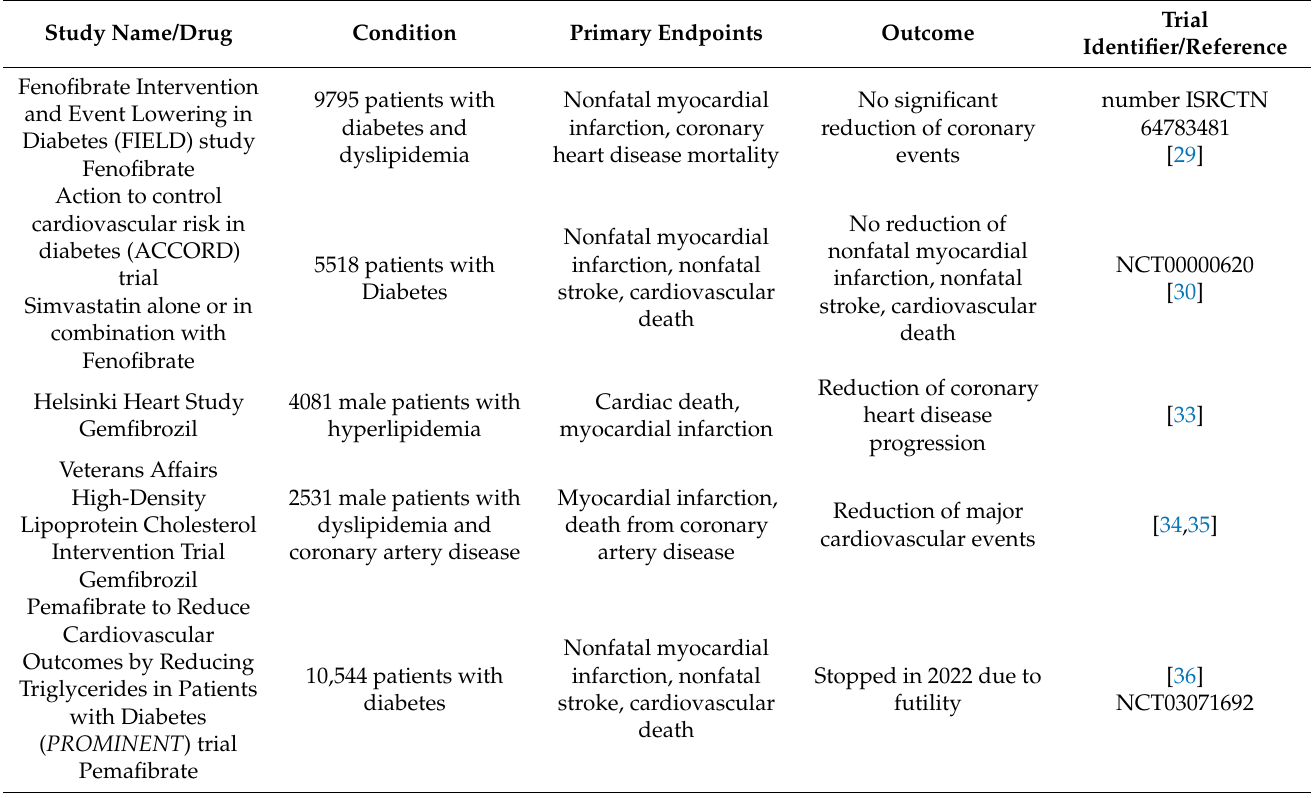
Table 1. Summary of Clinical Trials with PPAR α agonists for Cardiovascular